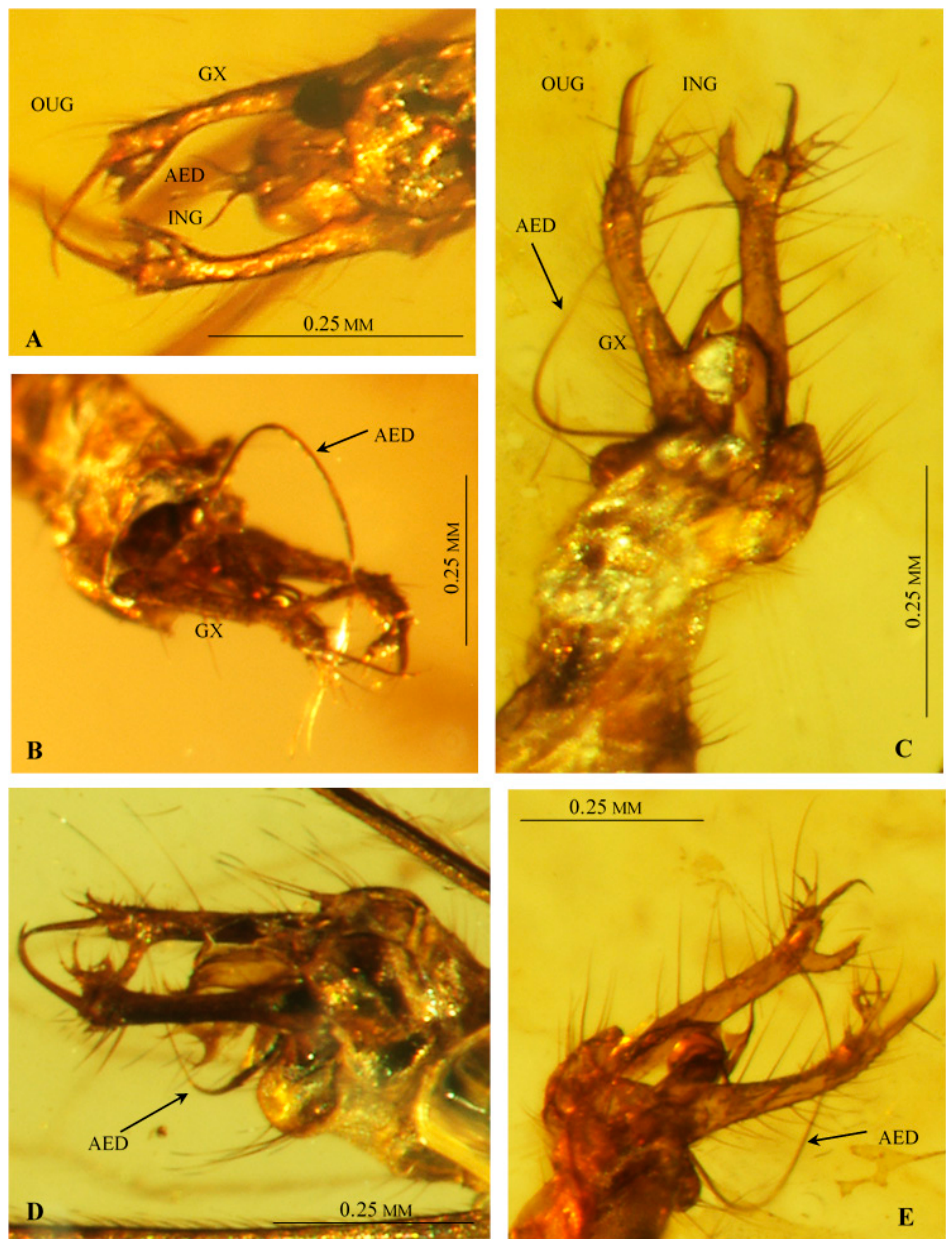
Figure 4. Drinosa prisca Podenas et Poinar, 2009 [13], hypopygium. ( A ) No. MP/4022 (ISEA PAS), dorsal view; ( B ) No. MP/4068 (ISEA PAS), latero-ventral view; ( C ) No. MP/4072 (ISEA PAS), latero-ventral view; ( D ) No. MP/4070, lateral view; ( E ) No. MP/4072 (ISEA PAS), latero-dorsal view. Abbreviation as in Figure 2.